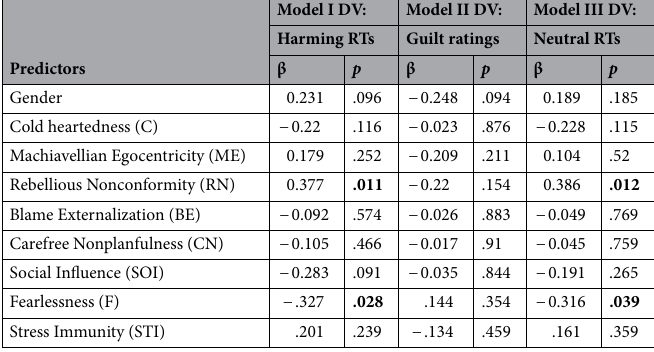
Table 2. Standardized coefficients of the multiple regression